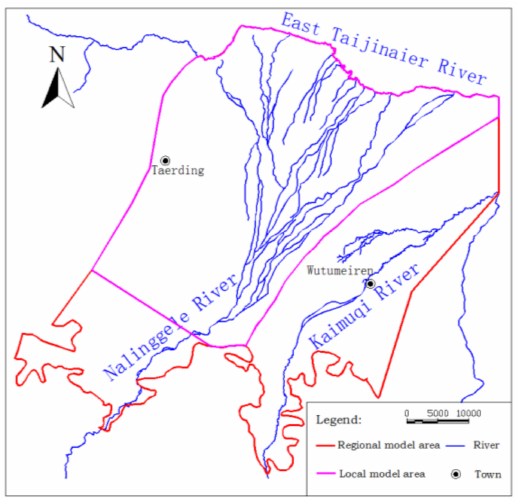
Figure 13. Modeling range of the local model